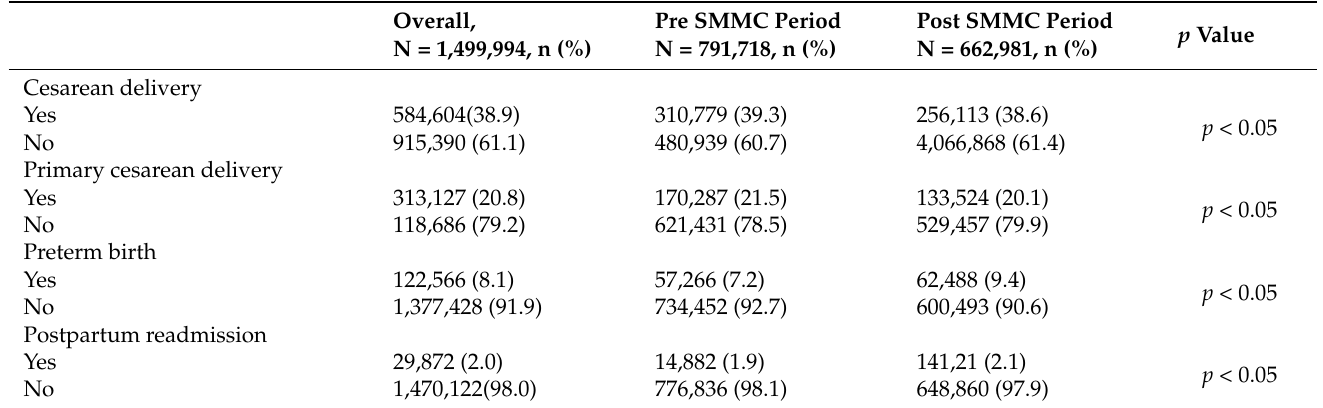
Table 1. Baseline characteristics of the patients overall, in the pre-period and post-period of the implementation of mandatory managed